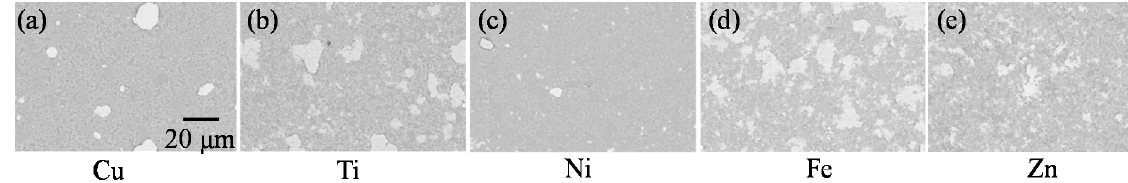
Figure 12. Surface SEM images of metal-coated Al 2 O 3 balls by MCT.